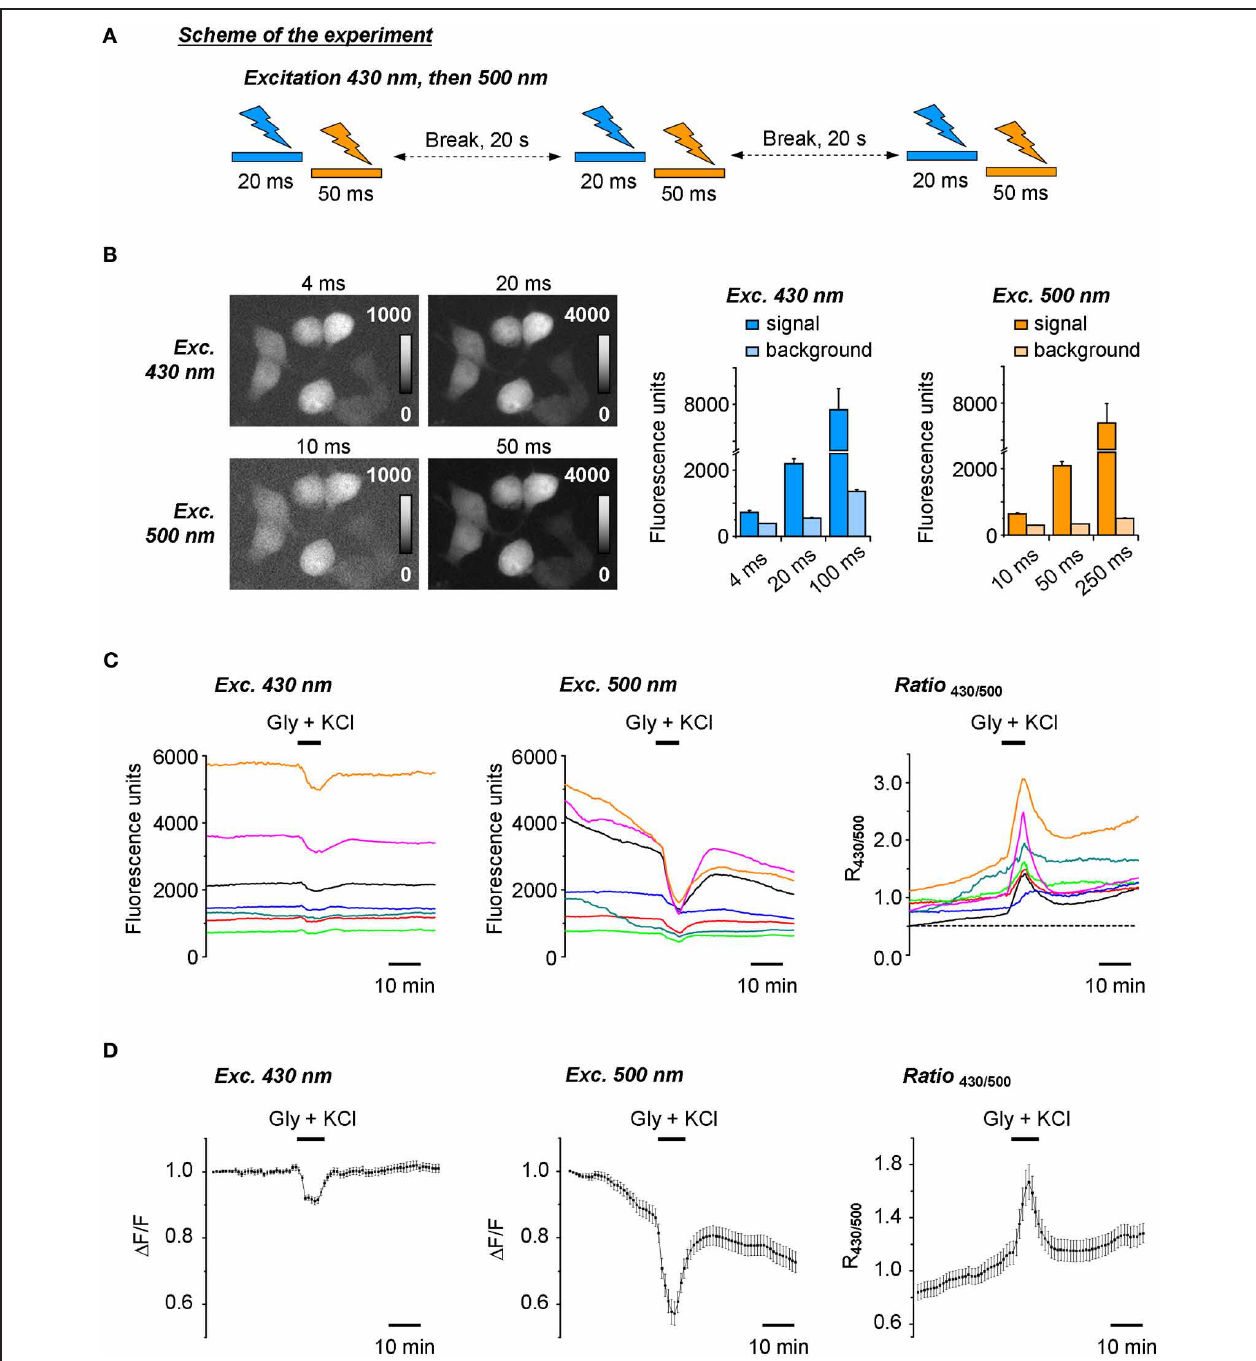
FIGURE 2 | Ratiometric recording of the Cl-Sensor fluorescence using a non-adjusted fluorescence setup. (A) Scheme of the protocol of experiment. Cl-Sensor was excited every 20s using two consecutive light pulses through first 430nm and then 500nm excitation filters. (B) Examples of fluorescence images obtained by excitation at 430nm and 500nm at different exposure times as indicated. Plots illustrate the mean ± SEM of fluorescence intensity measured on the transfected cells (signal) and region free of cells (background) ( n = 15 regions measured in the same sample). (C) Fluorescence responses of individual cells to 5min application of the external solution containing 50 μ M glycine and 100mM KCl. Examples were